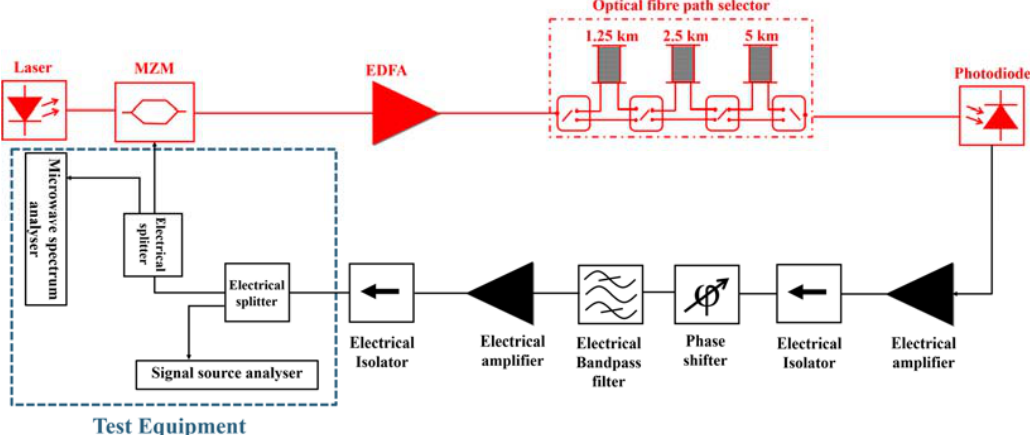
Figure 13. OEO application to measure the phase noise, SMSR and free spectral range (FSR) of the electrical bandpass filters at different optical fiber lengths. Reprinted from Reference [100].